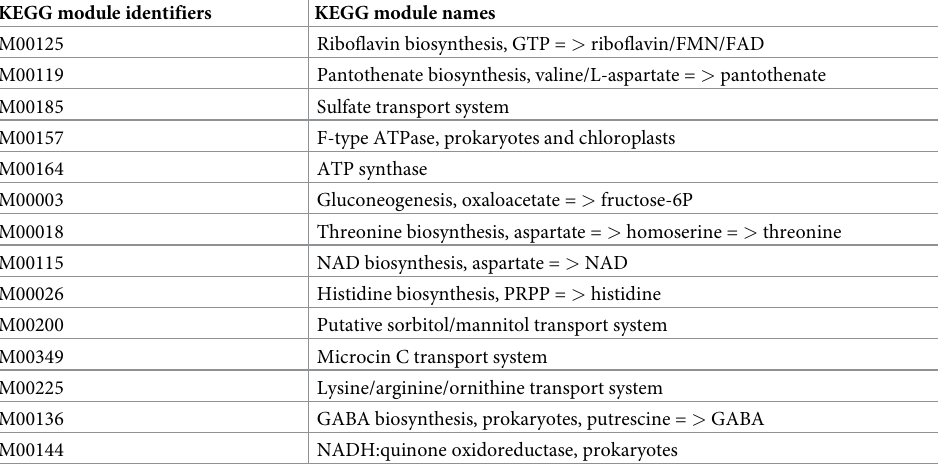
Table 4. Abundant KEGG modules in normal